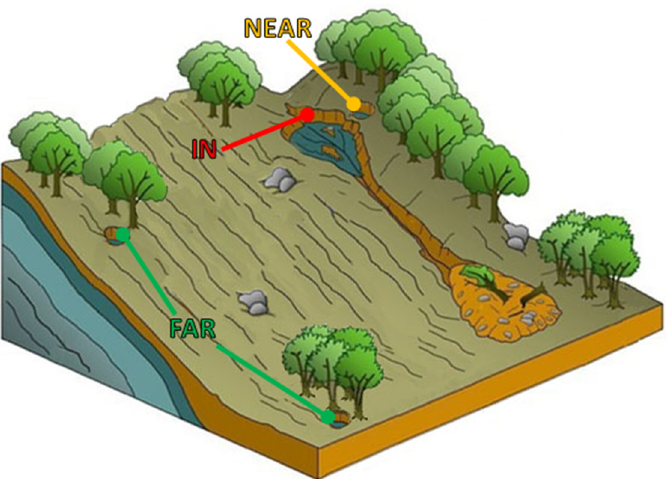
Figure 8. Location and tectonic setting of the study area (coordinate system: Gauss-Boaga, west zone).